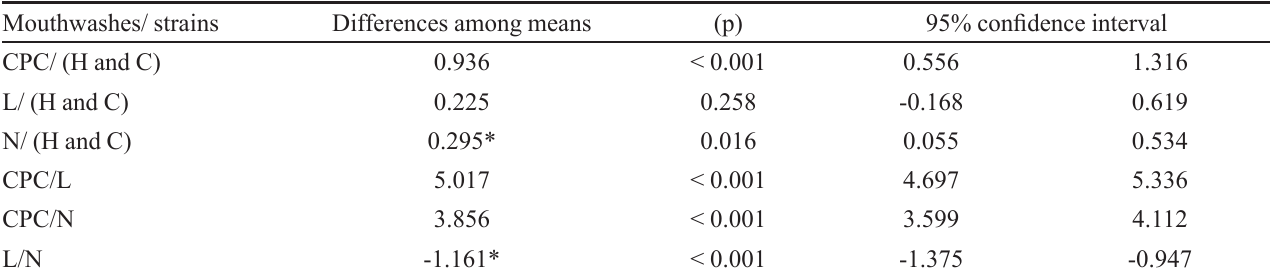
Table V - Analysis of variance with repeated measures of MID for the three antiseptic mouthwashes (CPC, L and N) in two groups of strains, community and hospital (C,H) Mouthwashes/